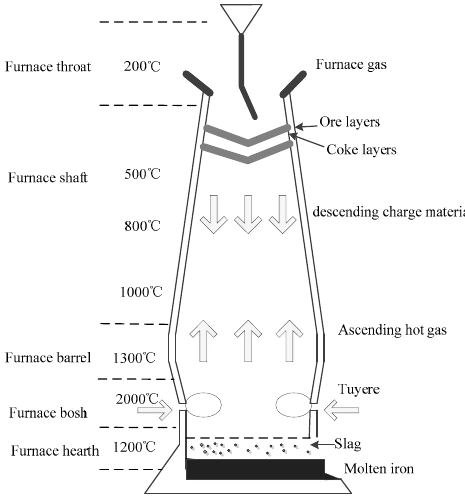
Figure 3. Blast furnace ironmaking process.